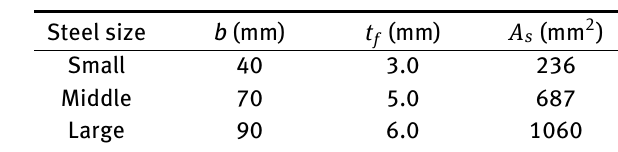
Table 2: Geometrical parameters for angle section